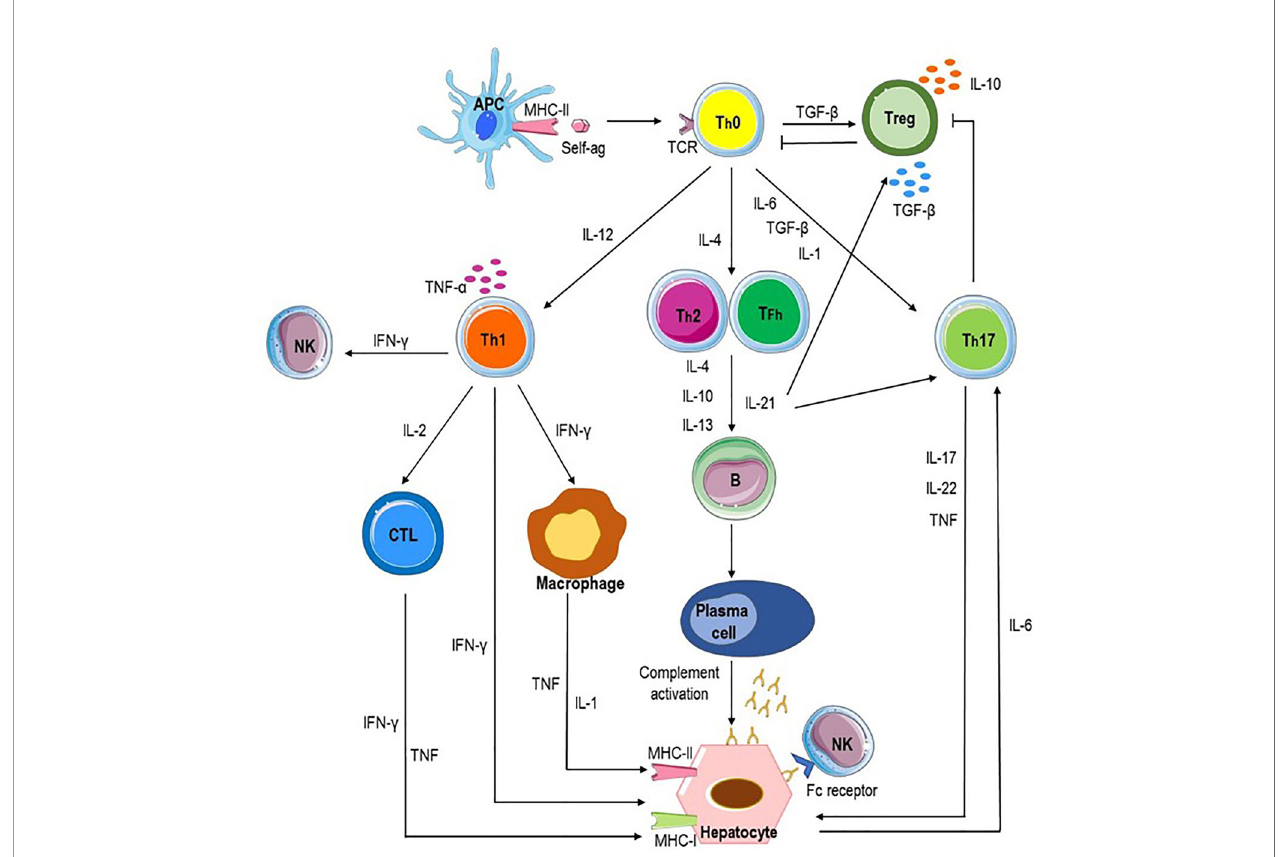
FIGURE 4 | Potential pathways of autoimmune attack of hepatocytes in AIH. Autoimmune-mediated liver damage in AIH is likely induced by an immune response to liver autoantigens. Antigen-presenting cells (APC) present autoantigenic peptide to naive CD4 + T helper cells (Th0), which release proin fl ammatory cytokines (IL-1, IL- 4, IL-12, IL-6, and transforming growth factor beta, TGF- b ) resulting in the differentiation of regulatory T cells (Treg), Th1, Th2, and Th17 cells. Each cell subset releases cytokines which lead to a cascade of events culminating with the autoimmune attack of hepatocytes. Liver cell destruction could derive from the activation of cytotoxic T lymphocytes (CTL) through cytokines released by Th1 and activated macrophages; Th2 cells secrete IL-4, IL-10, and IL-13 which trigger B cell maturation into plasma cells which produce autoantibodies and induce antibody-dependent cellular cytotoxicity and complement activation. Th17 cells release proin fl ammatory cytokines such as IL-17, IL-22, and tumor necrosis factor alpha (TNF- a ), inhibit Treg cells and stimulates hepatocytes to secrete IL-6 which further ampli fi es Th17 cell activation. Tfh (T follicular helper) cells participate to activation and differentiation of B cells in antibody-secreting plasma cells and release IL-21, a regulator of Treg cell differentiation and Th17 cell